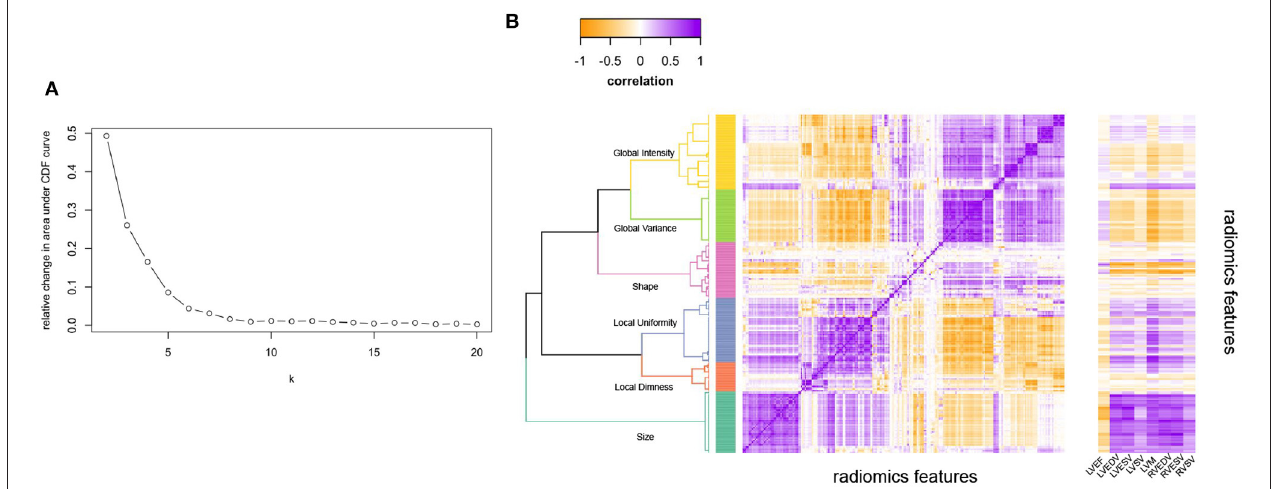
FIGURE 1 | Illustrating the clustering method and approach to defining the number of radiomics feature clusters for the radiomics features. (A) Illustrates the relative change in area under the CDF (Consensus Cumulative Distribution Function) curve of the y axis with increasing number of clusters (k on x axis), with the curve levelling off at six clusters. (B) Is the correlation heatmap illustrating the six defined clusters, with the darkest purple indicating perfect positive correlation and darkest yellow perfect negative correlation. The dendrogram indicates the six clusters from hierarchical clustering. The ribbon on the right of (B) Illustrates correlation of each radiomics feature with the conventional metrics indicated on the x-axis. LVEDV, left ventricular end-diastolic volume; LVEF, left ventricular ejection fraction; LVESV, left ventricular end-systolic volume; LVM, left ventricular mass; RVEDV, right ventricular end-diastolic volume; RVESV, right ventricular end-systolic volume; RVSV, right ventricular stroke